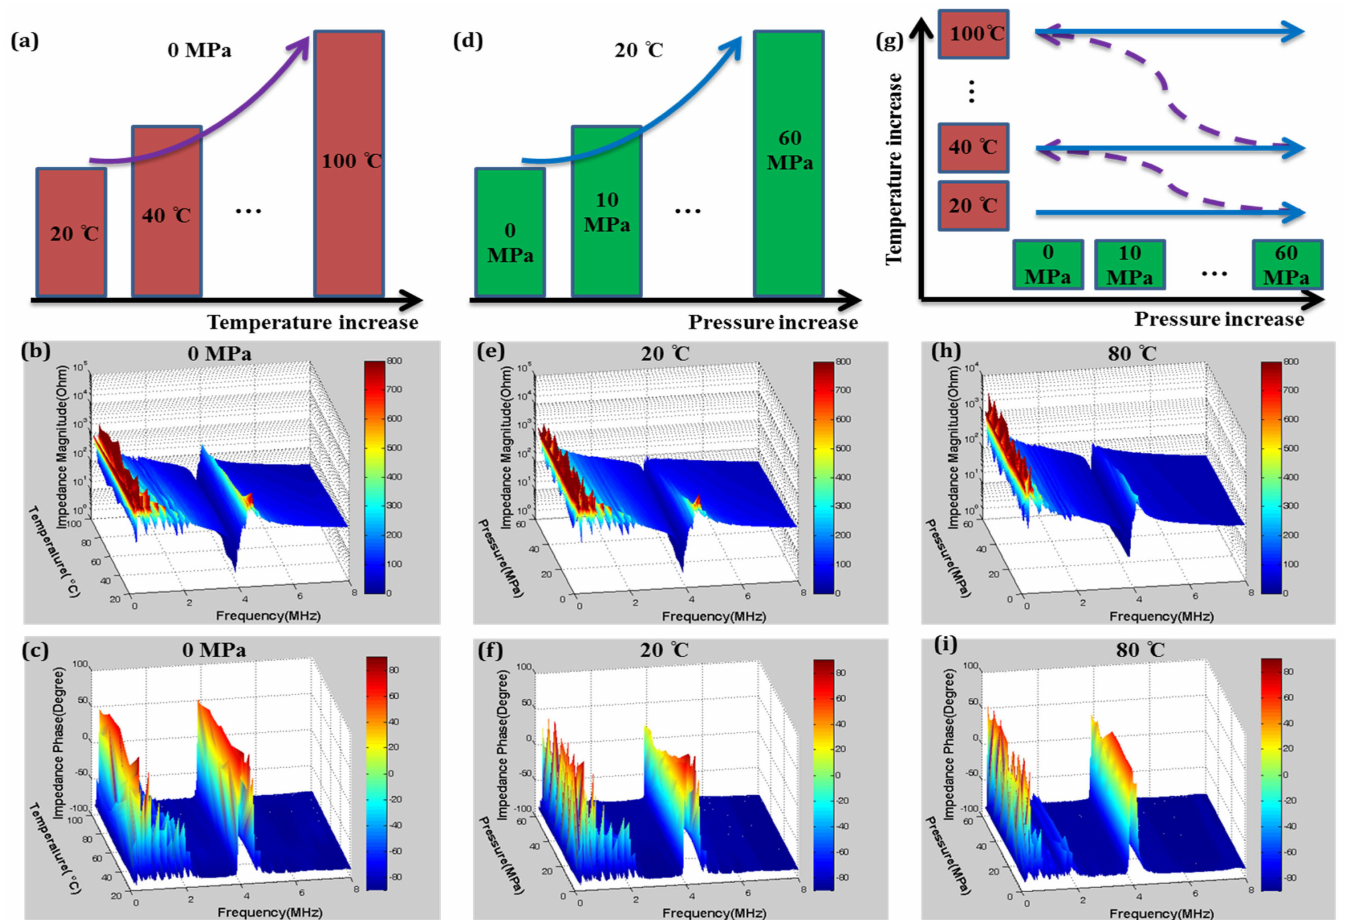
Figure 3. Characterisation of Mn:PIN-PMN-PT: ( a ) Configuration for variation of temperature at pressure of 0 MPa with measurement of ( b ) impedance magnitude and ( c ) impedance phase; ( d ) Characterisation configuration for variation in pressure at ambient temperature with measurement of ( e ) impedance magnitude and ( f ) impedance phase; ( g ) Characterisation configuration for variation in temperature and pressure with measurement of ( h ) impedance magnitude and ( i ) impedance phase.